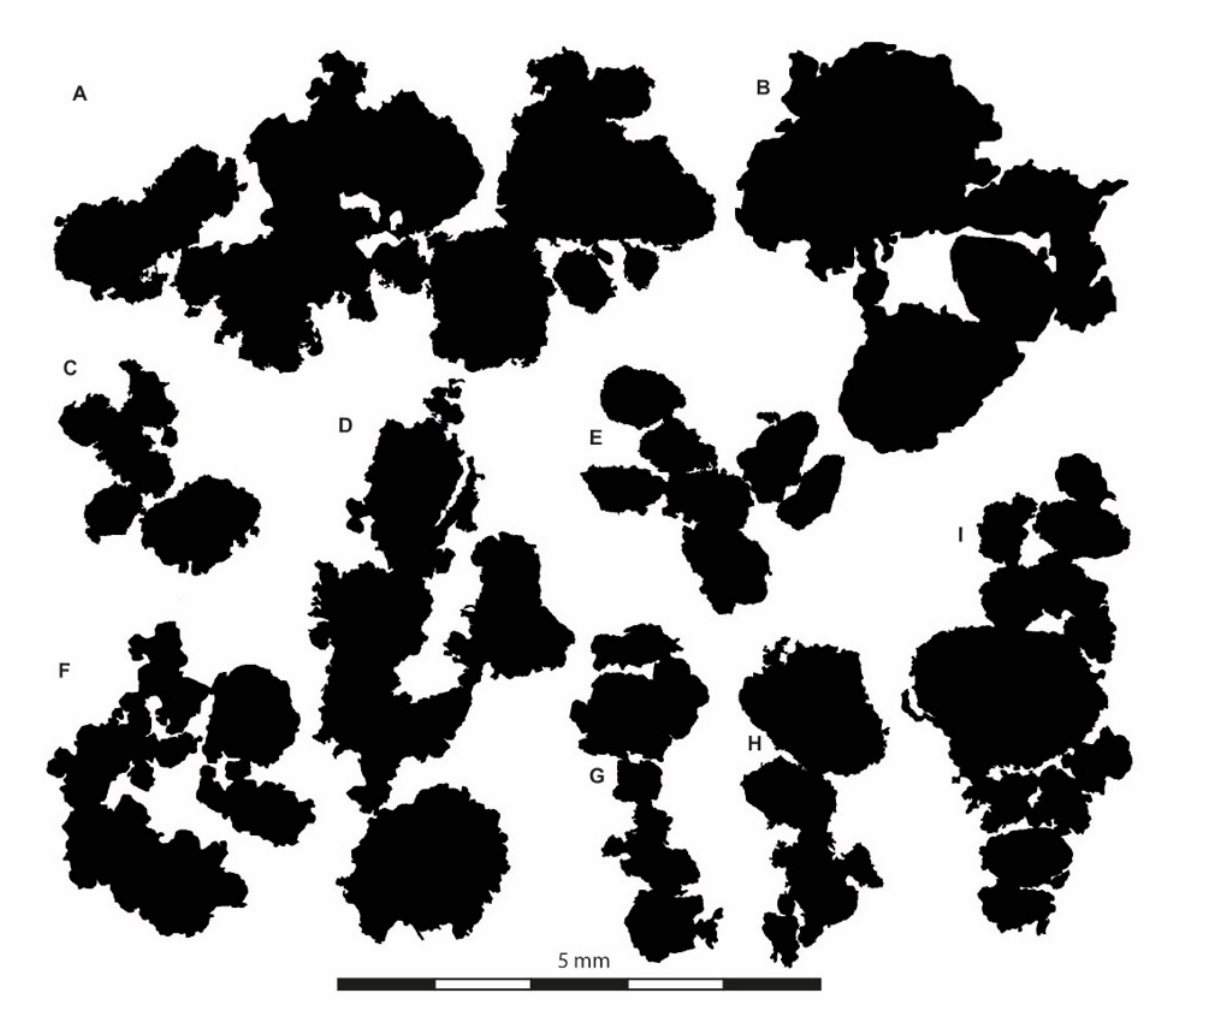
Figure 5: 2D masks of ash agglutinates derived from BSE images at 150 ˆ